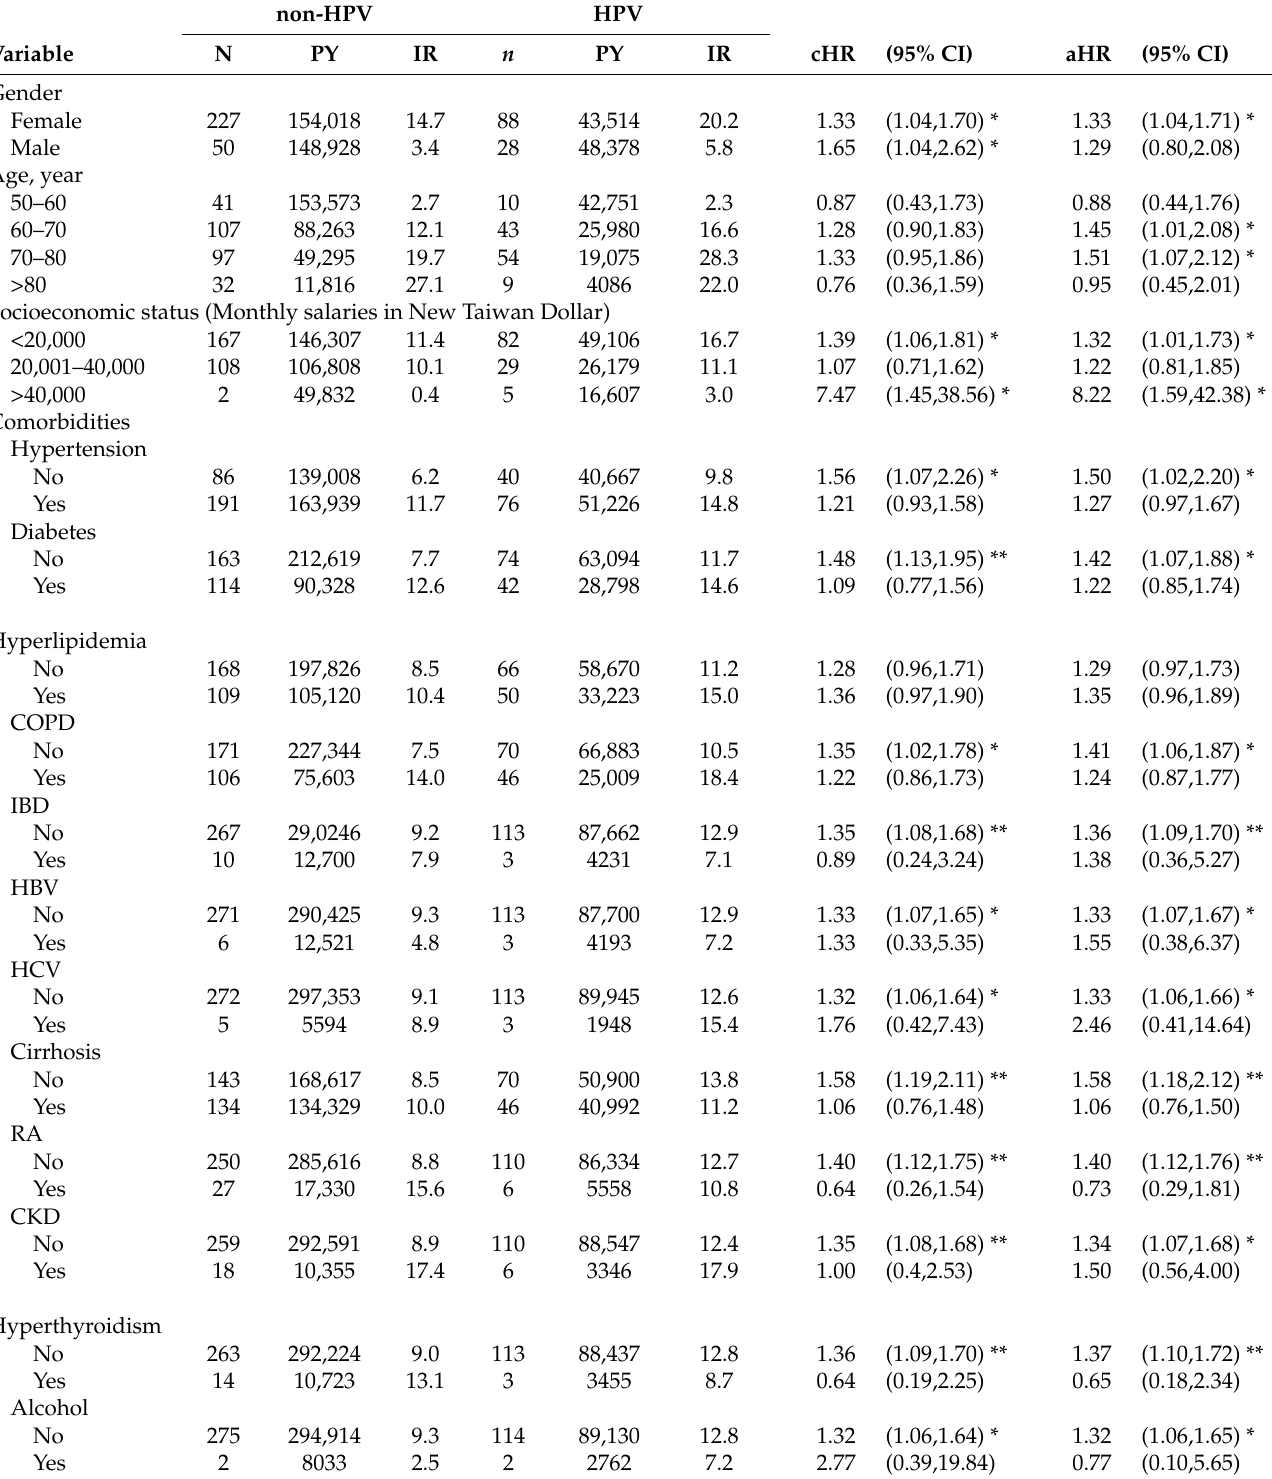
Table 3. Subpopulations at risk of HPV-associated osteoporosis in patients with HPV infections. non-HPV